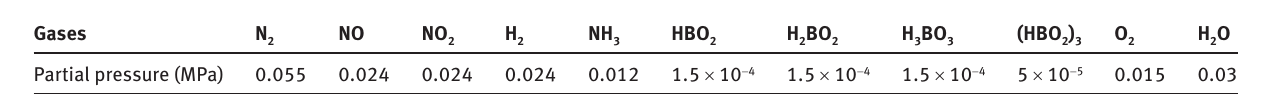
Table 2: Partial pressures of the reactions and products